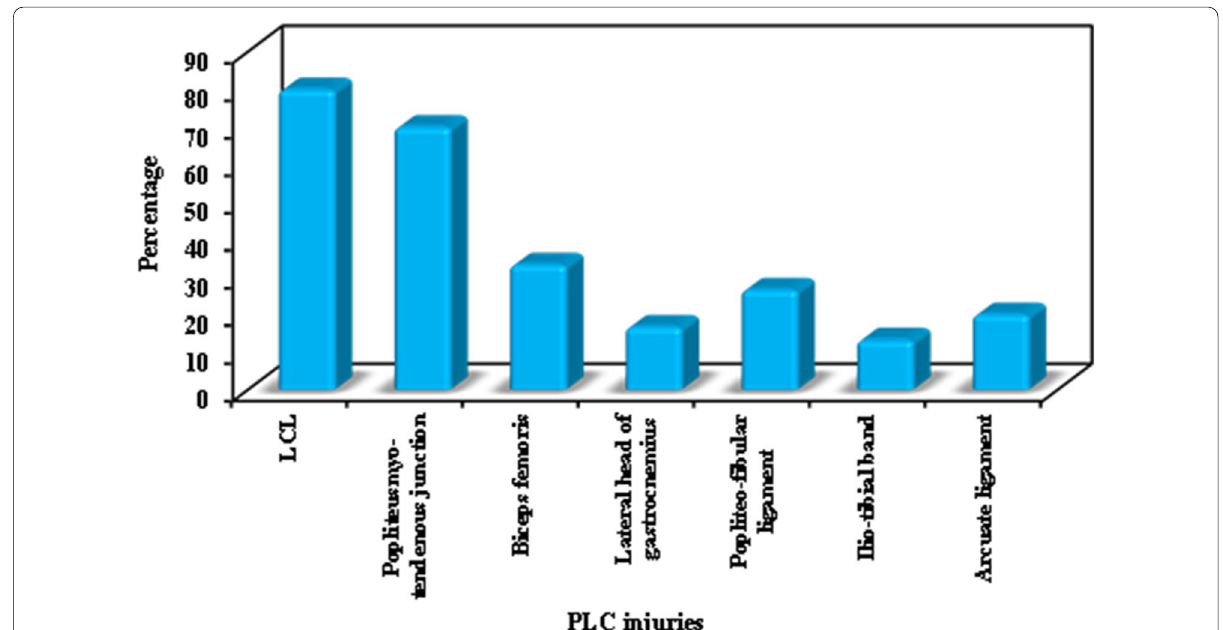
Fig. 2 Incidence of different PLC structures affected in all PLC‑injured studied cases